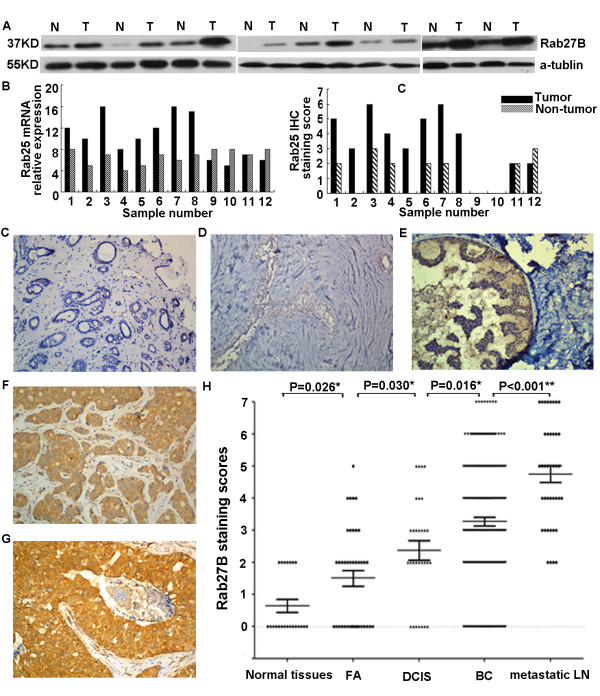
The expression pattern of Rab27B in BC tissues. (A) Western blot analysis of Rab27B protein expression in 8 representative paired BCs (T) and NATs (N). Equal loading of protein is shown by α-tubulin. (B) Rab27B mRNA and protein expression in human BCs (T) and NATs (N) by Real-time PCR (left panel) and IHC analysis (right panel). Rab27B mRNA and protein expression in 12 primary BCs is upregulated compared to their NATs. (C) Negative staining of Rab27B in normal breast tissue. (D) Weak staining of Rab27B in FA. (E) Moderate staining of Rab27B in DCIS. (F) BC cells showing strong staining of Rab27B. (G) Strong Rab27B staining in metastatic lymph nodes. (H) Statistical analysis revealed a significantly ascending pattern of Rab27B expression ranging from NAT to BC to distant metastases nodes.